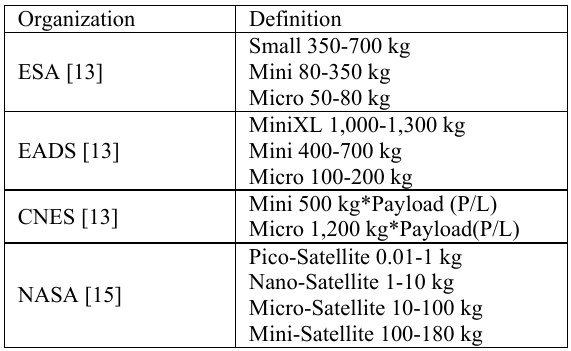
Table 1. Definitions for Small